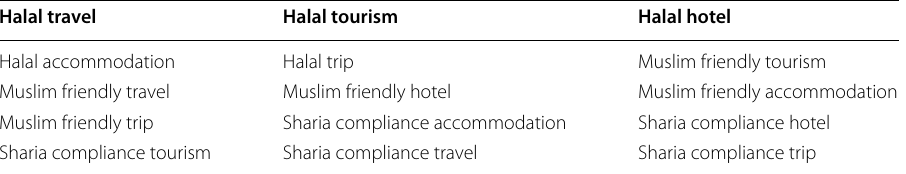
Table 1 List of keywords used in Twitter